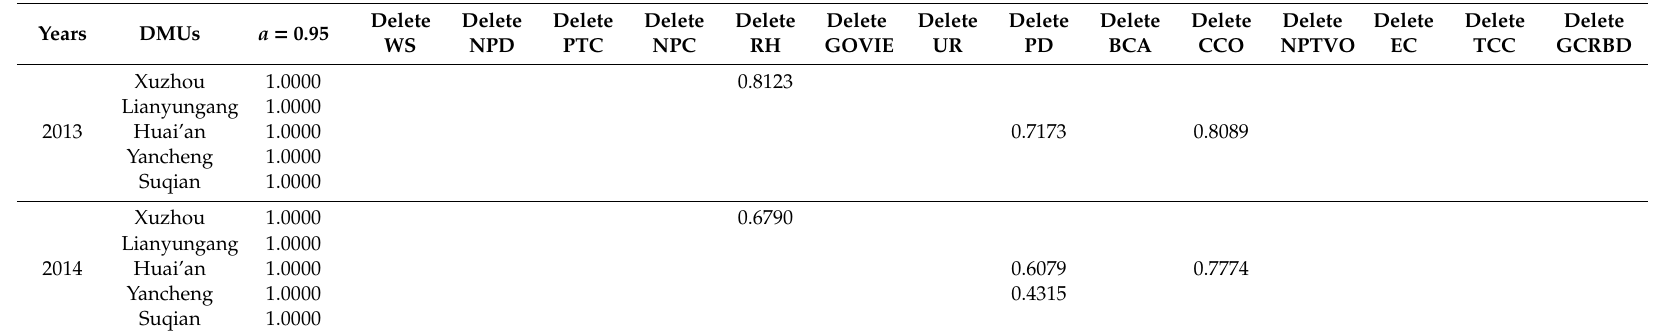
Table A15. The changes of stochastic e ffi ciency value by deleting single input variable in Northern Su ( α =